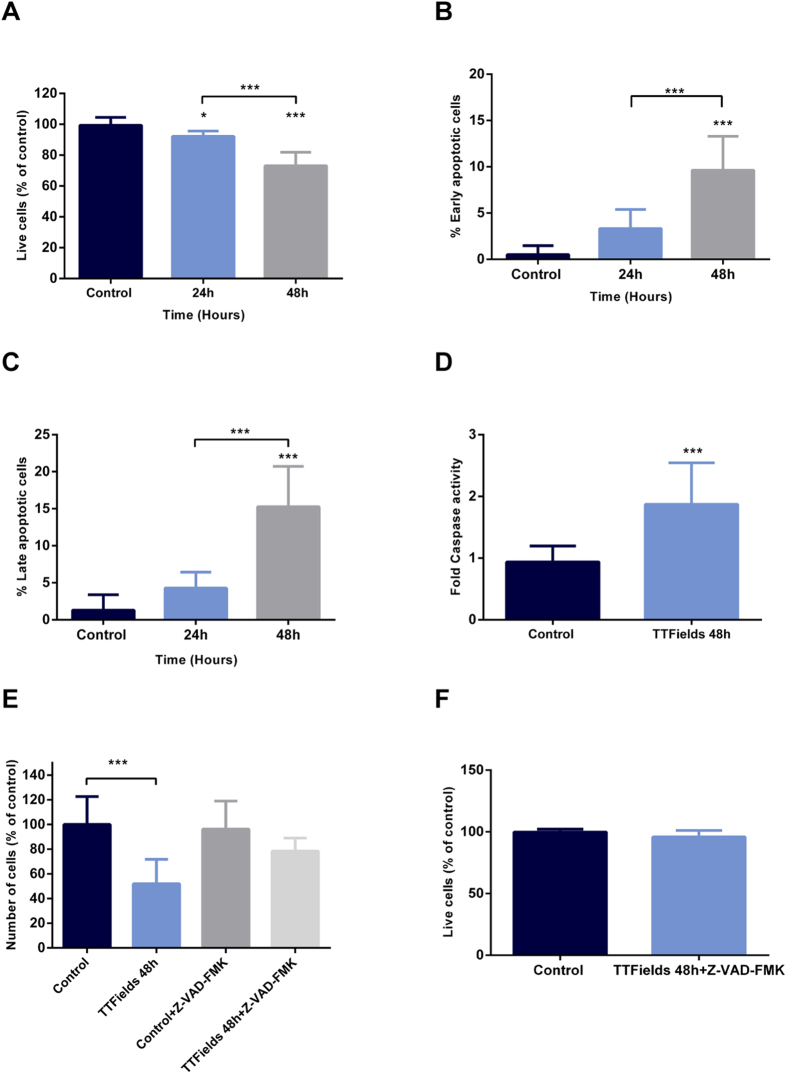
TTFields Kill Cancer Cells by Triggering Caspase Mediated Apoptosis.A2780 cells were treated with TTFields for 48 hours. (A–C) Cell samples were collected and evaluated for apoptosis. (A) Live cells. (B) Early apoptotic cells. (C) Late apoptotic cells. (D) Caspase activity was evaluated using flow cytometry analysis following 48 hours of TTFields application. (E,F) Effect of pan-caspase inhibition by Z-VAD-FMK on A2780 response to TTFields treatment. (E) Evaluation of number of cells (unpaired t-test). (F) Evaluation of apoptosis. 0.05 > *p > 0.01, and ***p < 0.001 from control group.